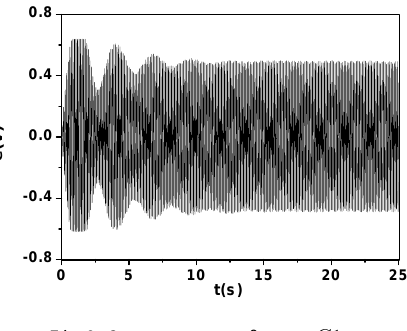
Fig. 3. System response for case C 1